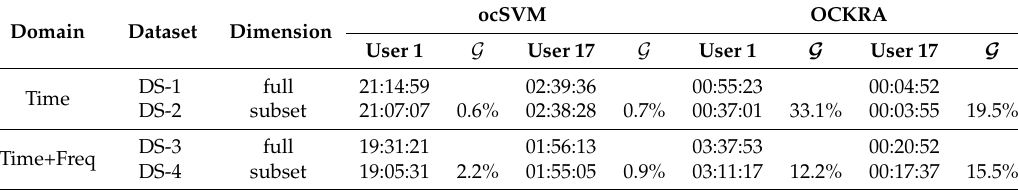
Table 11. Execution time required by the classifier training phase using different datasets. The G column indicates the gain in percentage when using a subset against the full feature vector. Experiments